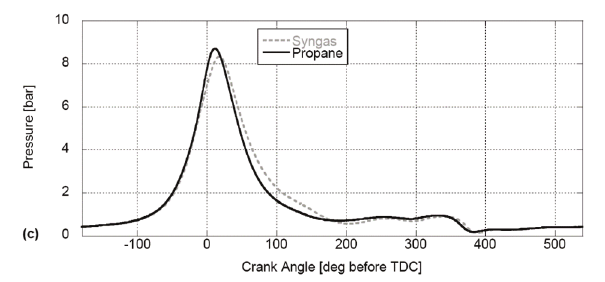
Fig. 5. The course of pressure in the combustion chamber as a function of the angle of rotation of the crankshaft for "Two Loads" [13]